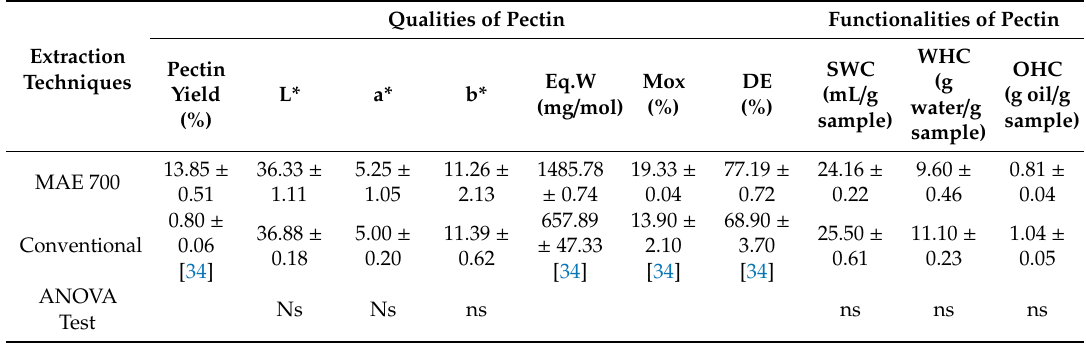
Table 1. Qualities and functionalities of mango peel pectin extracted by conventional and MAE techniques.